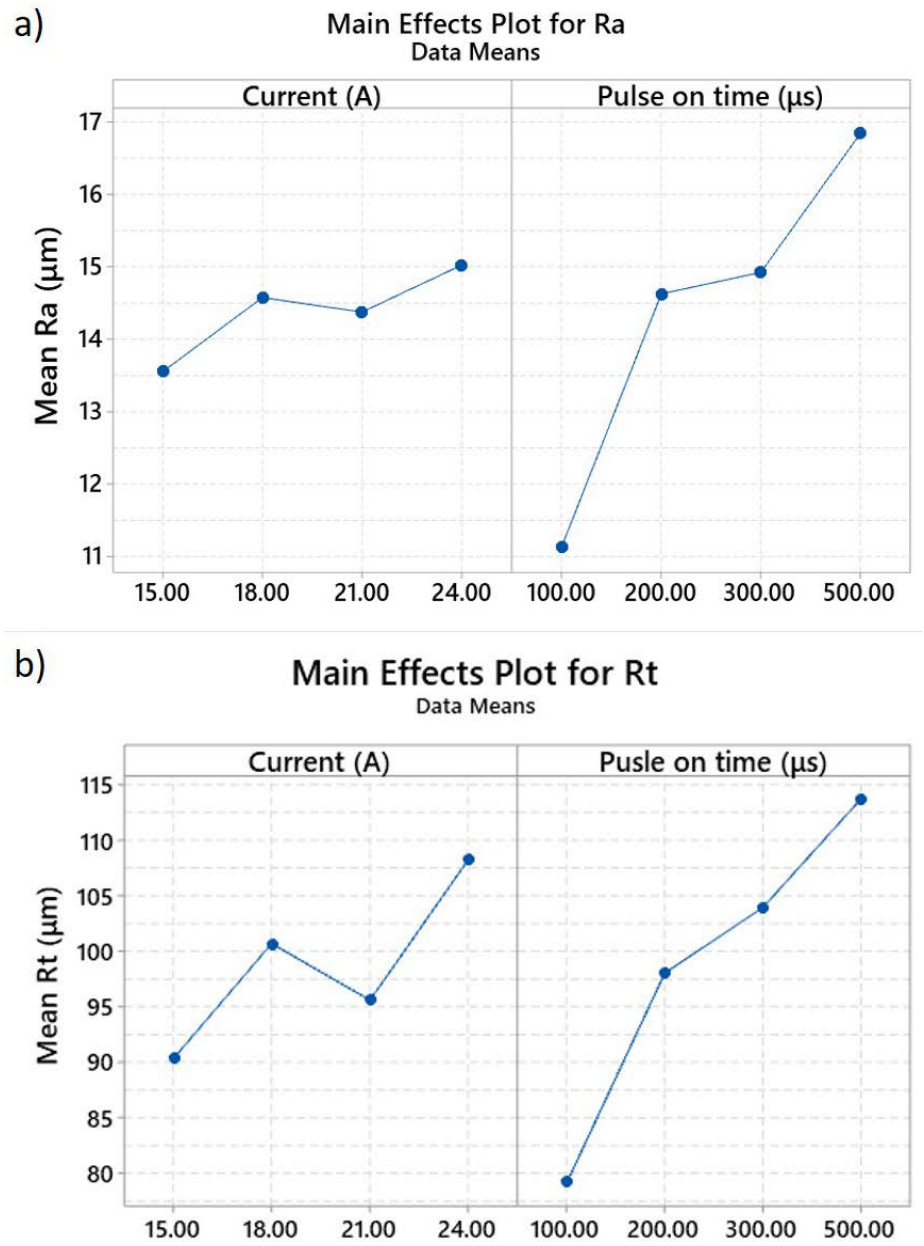
ff ects plot for ( a ) Ra. ( b ) Figure 3. Main effects plot for ( a ) Ra. ( b ) Rt. Figure 3. Main e